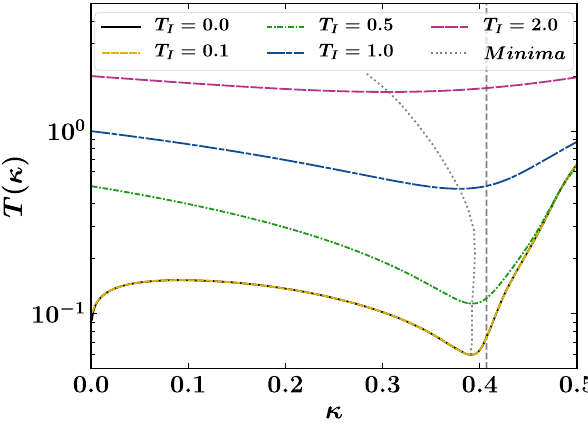
FIG. 8. NLCE results for the temperature of the Gibbs ensemble describing observables after equilibration, following quantum quenches κ I ¼ 0 → κ within the ANNNI Hamiltonian, for initial thermal states at temperatures T I ¼ 0 . 0 , 0.1, 0.5, 1.0, and 2.0. For those initial temperatures, minima in T ð κ Þ occur at κ ≈ 0 . 391 , 0.391, 0.392, 0.379, and 0.306, respectively. The m locus of minima [ κ m ; T ð κ m Þ ] for a large number of initial FIG. 7. The transverse spin magnetization ( m z ) and the von temperatures T I is also shown. The vertical dashed lines mark Neumann entropy ( s ), per site (see the text), evaluated using the critical κ c ≈ 0 . 41 . NLCE in thermal equilibrium following quenches κ I ¼ 0 → κ with T I ¼ 0 , 0.1, 0.5, and 1.0. The main figures in (a) and (b) show dm z =d κ and ds=d κ , respectively, while the correspond- ing insets show m z and s . In (a), we also show results for m z in the ˆ H ð κ Þ ground state of (dotted lines) computed using iTEBD. The vertical dashed line marks the critical κ c ≈ 0 . 41